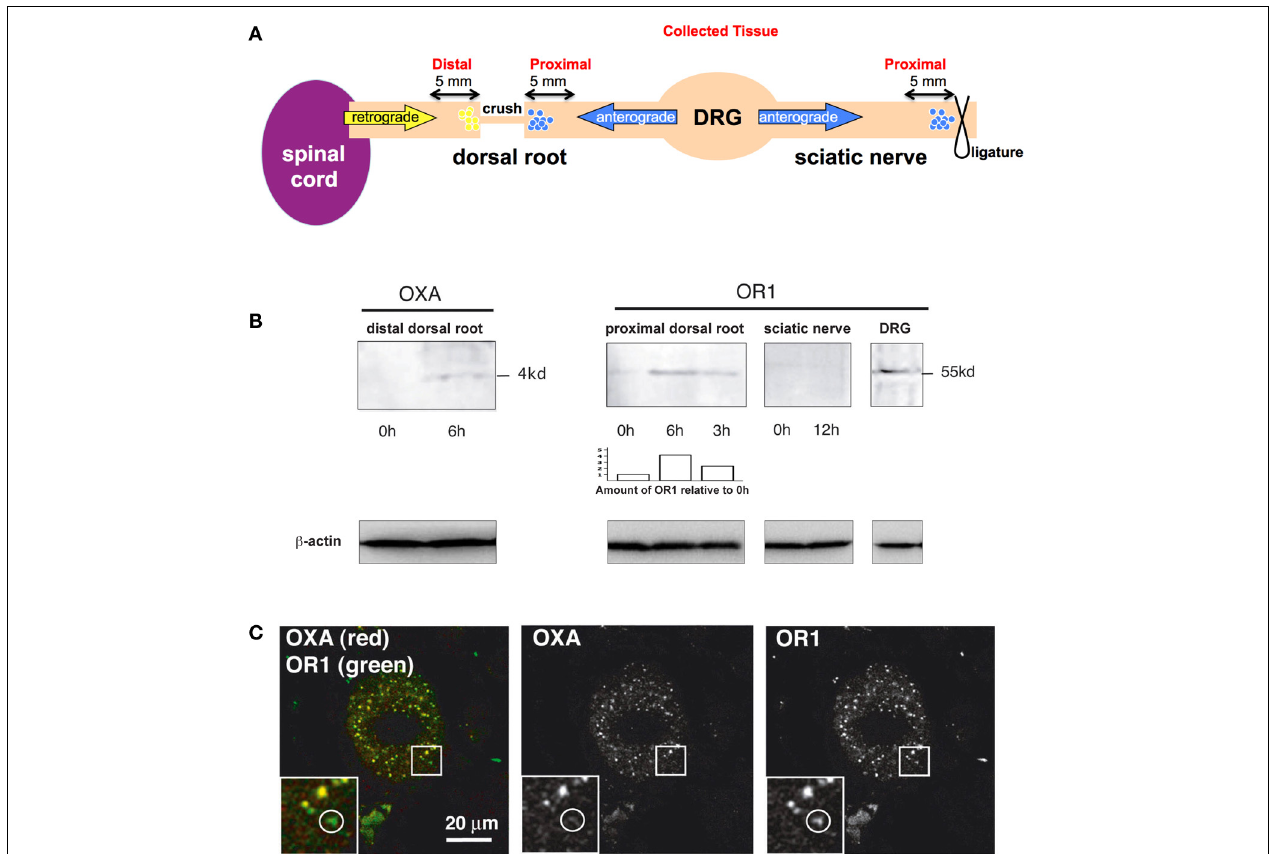
FIGURE 3 | OR1 and OXA are transported in dorsal root axons. (A) Scheme illustrating the crush and ligature experiments and indicating the sites where tissue samples were collected to measure OXA and OR1 accumulation. (B) Transport analysis (based on our previous work Delcroix et al., 2003). Left panel, OXA is accumulated after 6h in the dorsal root suggesting a retrograde transport. Right panel, 6 and 3h OR1 accumulation proximal at a crush site in the dorsal roots. The 0h lane has been loaded with an intact root from the